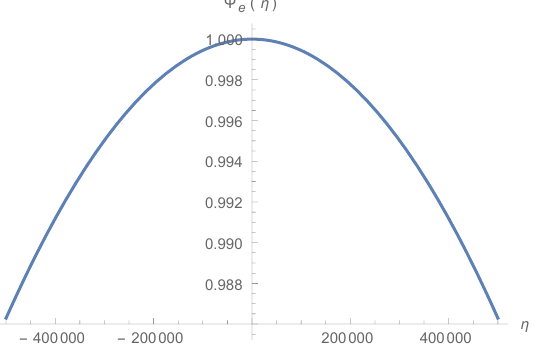
Figure 13. Time evolution of Ψ e in the Jordan frame for the initial conditions Φ e ( 0 ) = 10 − 2 , Ψ e ( 0 ) = 1, Φ (cid:48) ( 0 ) = 0, Ψ (cid:48) ( 0 ) = 0. The background evolution is the one obtained by assuming the same initial e e conditions as mentioned in the caption of Figure